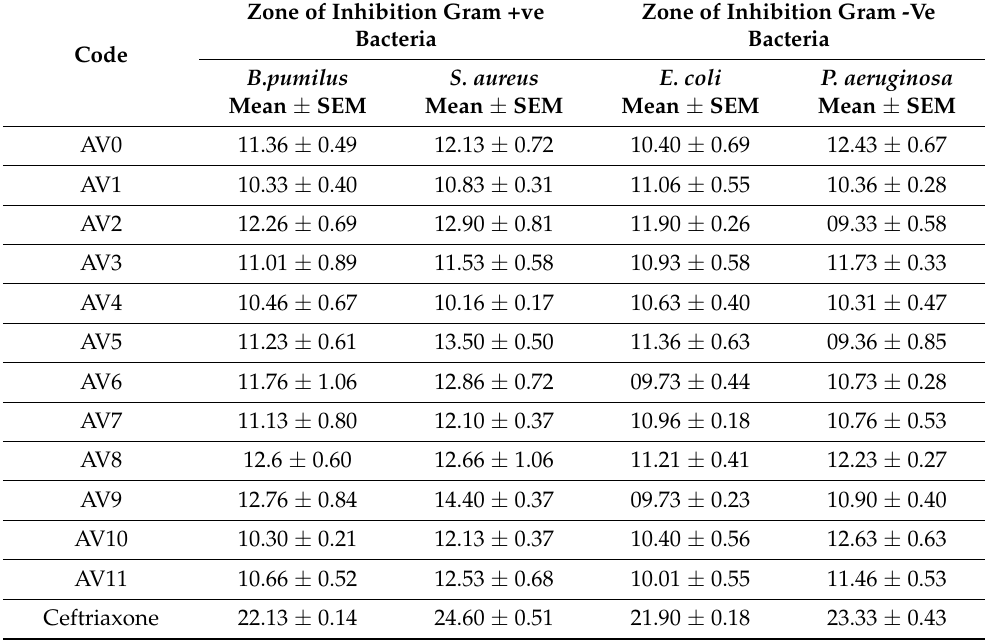
Table 6. Results of antibacterial activity of synthesized derivatives of2-(N-((2 (cid:48) -(2H-tetrazole-5-yl)-